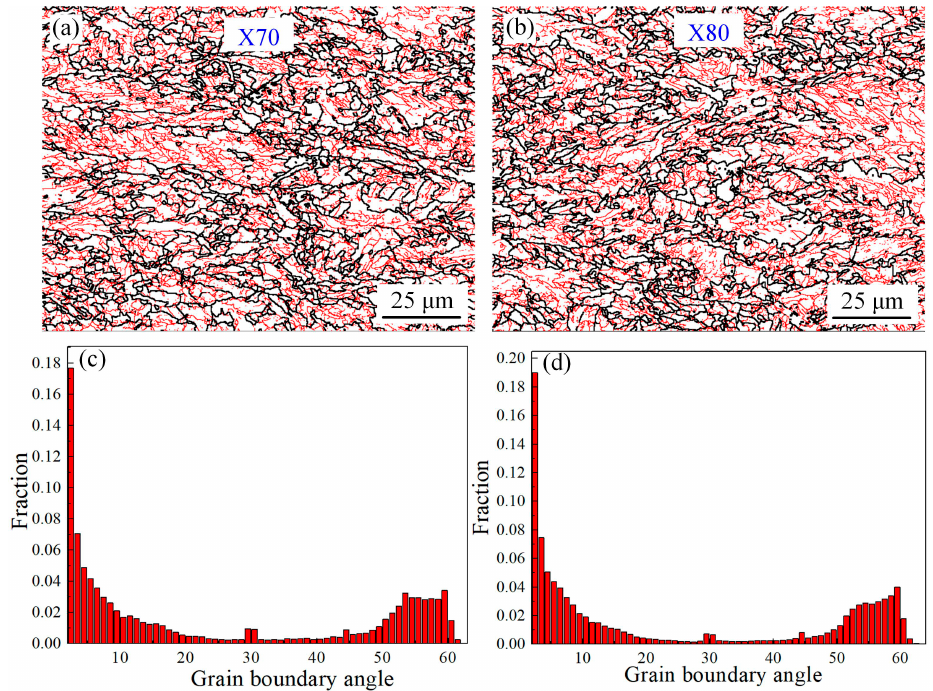
Figure 3. Grain boundary maps of the center region of X70 ( a , c ) and X80 ( b , d ). The black lines indicate the high-angle grain boundaries (>15°) and the red lines indicate the low-angle grain boundaries (<15°).